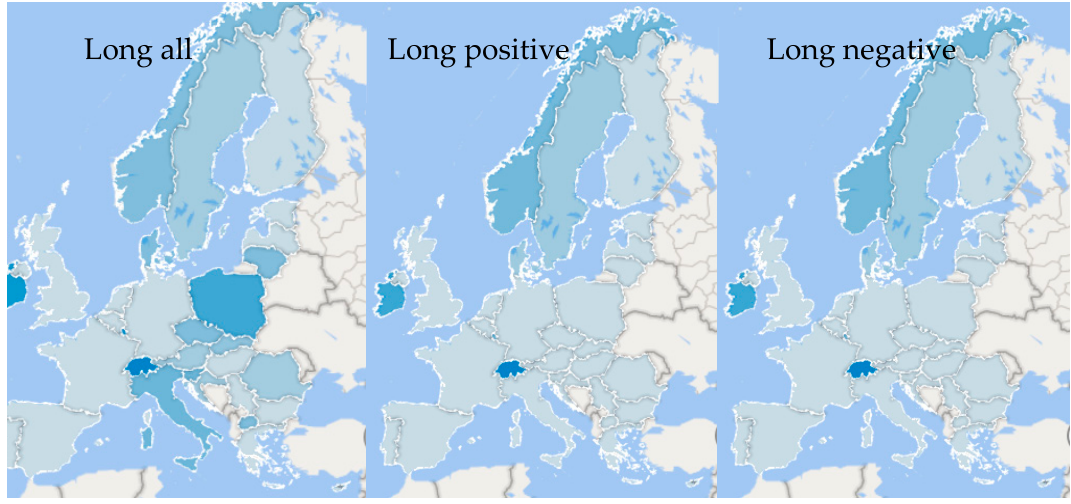
Figure 16. Numberofprecedencebycountry, longprecedenciesgroupEdubyeffect. Figure 16. Number of precedence by country, long precedencies group Edu by effect. Geospatial distribution.